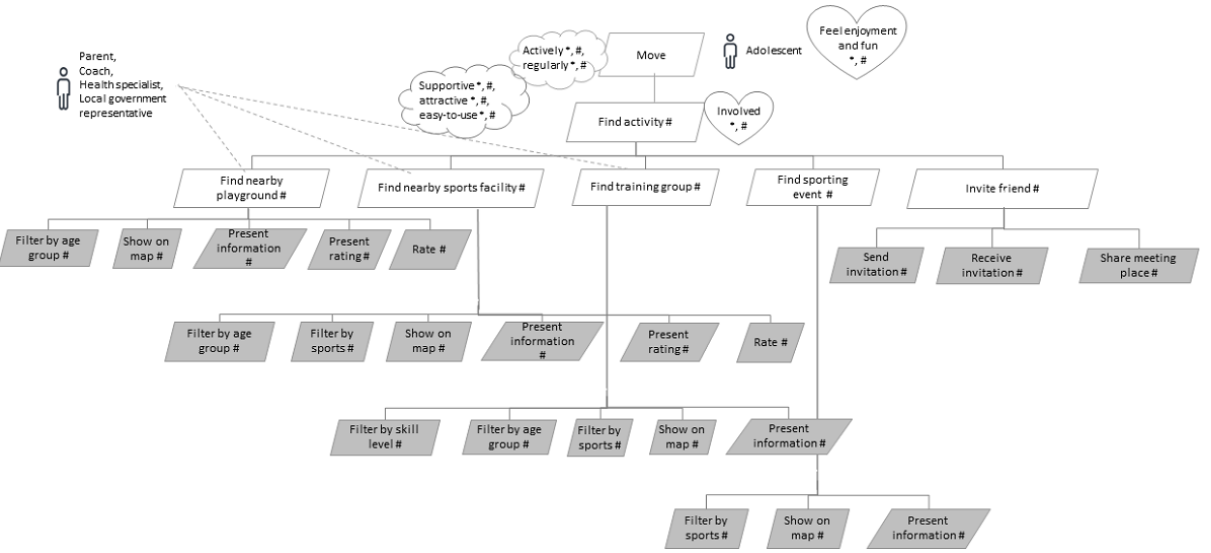
Figure 5. Sublevel models for functional goal “find activity.” The “*” in the model represents findings from the literature; the “#” represents suggestions by experts; gray rectangles represent functionalities at the level of user